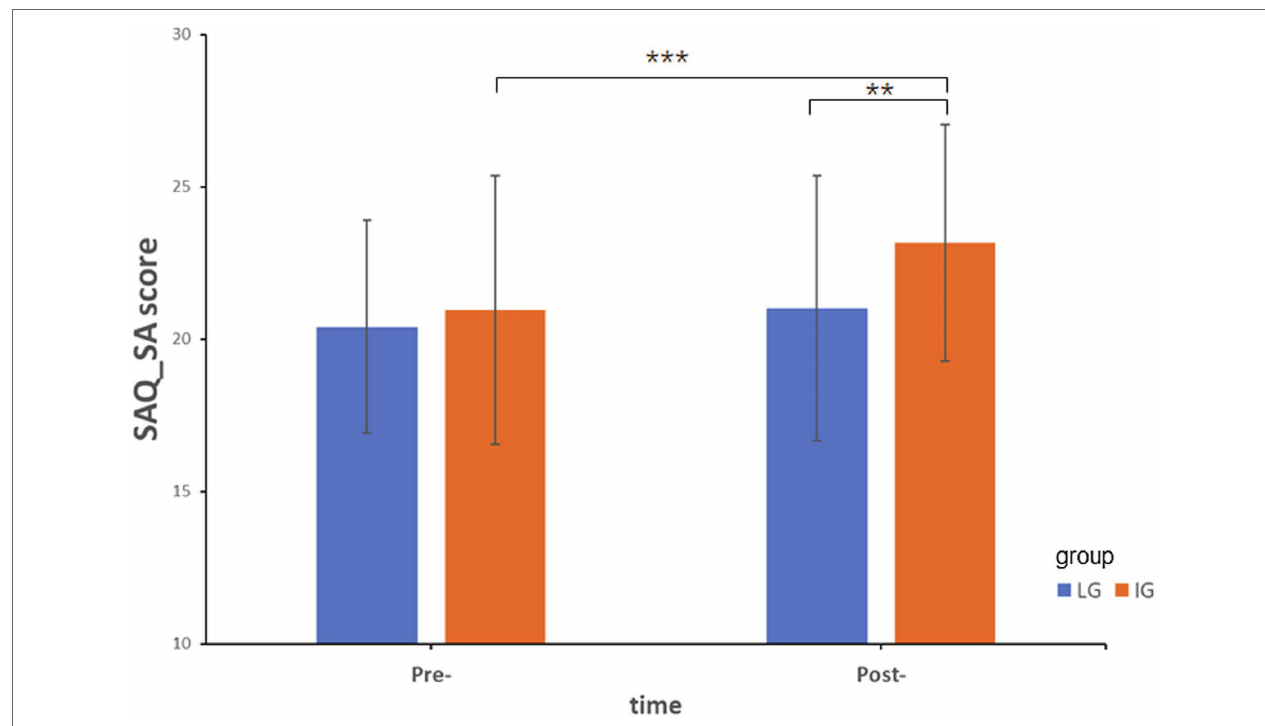
FIGURE 2 | The intervention effect for the score of self-acceptance dimension in SAQ. ** p < 0.01; *** p <